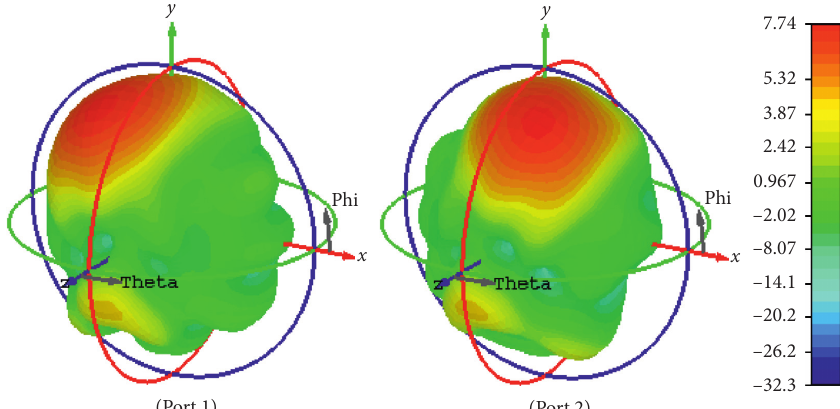
Figure 16: 3D Radiation pattern of the proposed MIMO antenna at 28GHz.